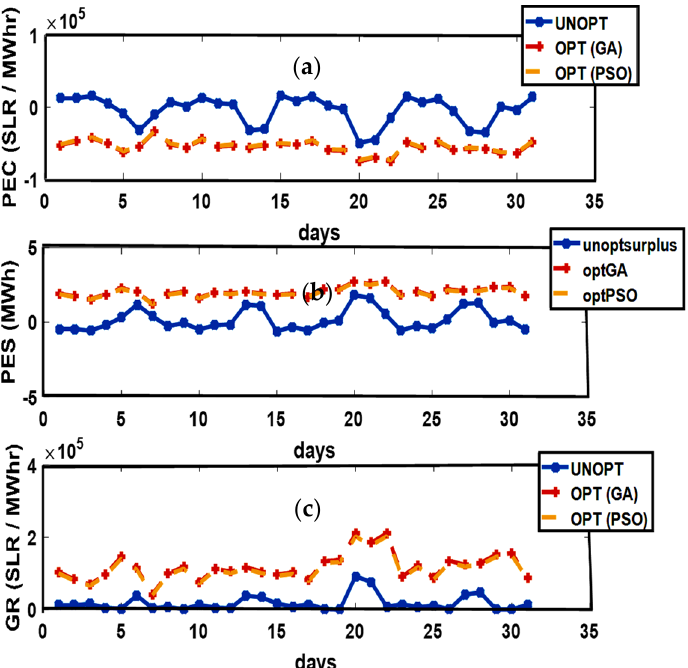
Figure 8. ( a ) Prosumer Energy Cost (PEC), ( b ) Prosumer Energy Surplus (PES), ( c ) Grid Revenue (GR).